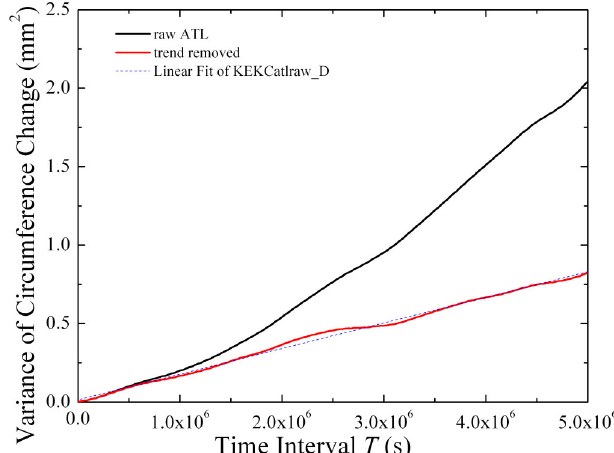
FIG. 3. Changes of rms vertical and horizontal orbits in TRISTAN ring (from [19]).